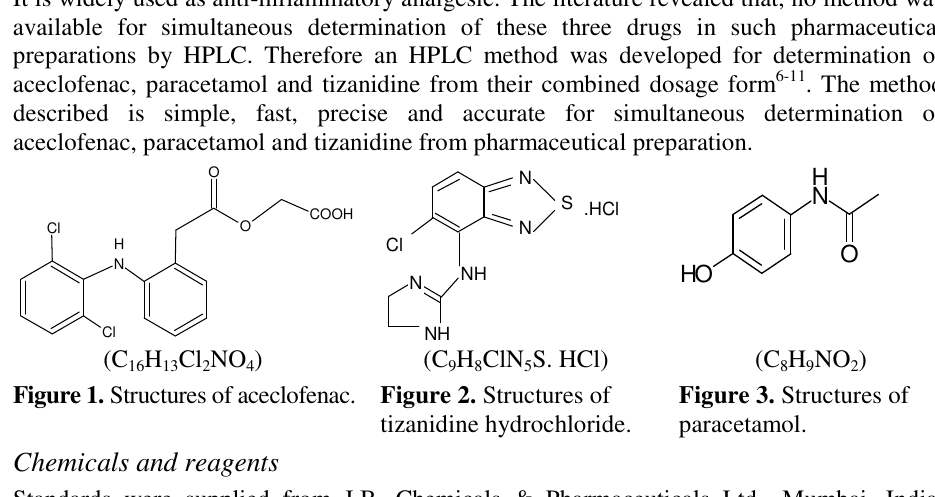
Figure 1. Structures of aceclofenac. Figure 2. Structures of